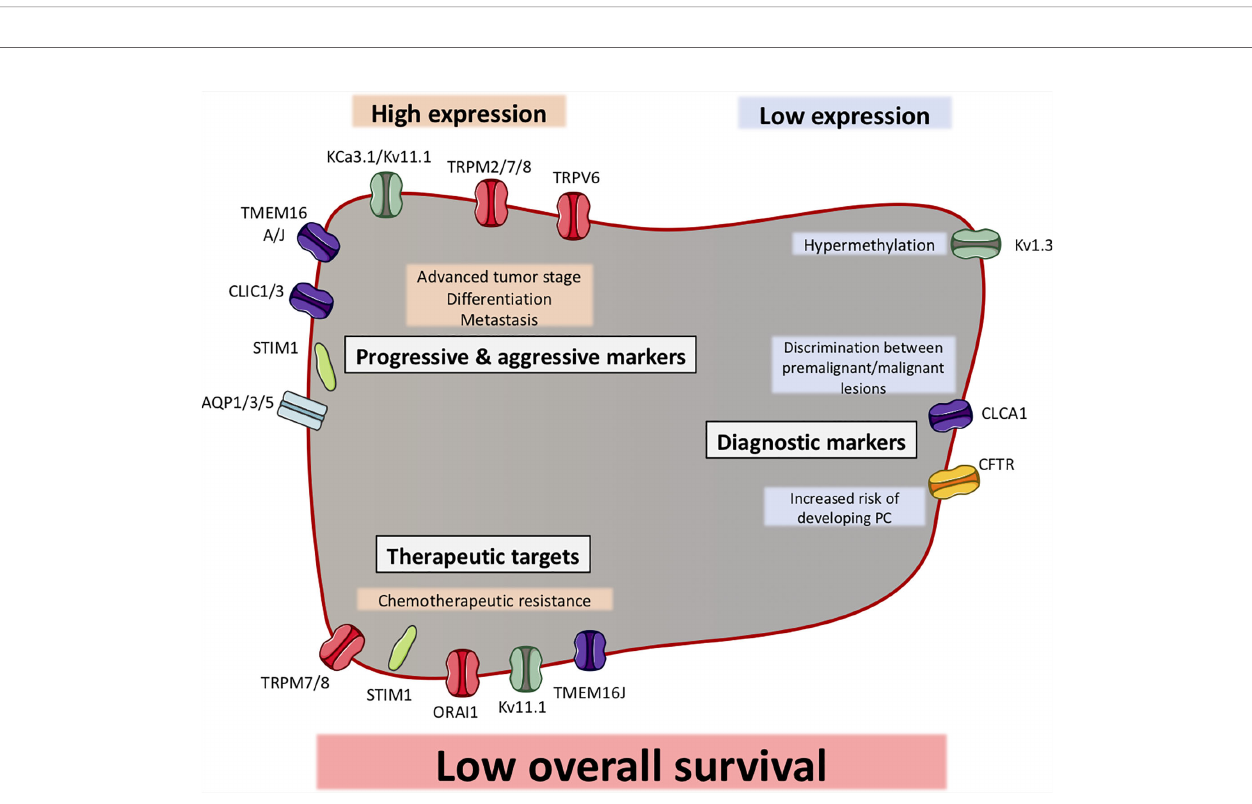
FIGURE 3 | Ion channels can function as biomarkers in pancreatic ductal adenocarcinoma (PDAC). Illustration of ion channels, where the expression has been shown to be correlated with clinical factors. Most of the ion channels show a high expression in PDAC, which correlates with clinical factors (indicated in grey boxes). Some ion channels have shown to be to have a low expression in PDAC, which correlates with other clinical factors. The ion channels are grouped as progression and aggressiveness markers, diagnostic markers or therapeutic targets. Among all ion channels, their expression (except CFTR) have been shown to be correlated with a low overall